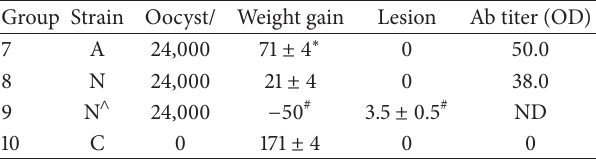
Table 3: White Leghorns were immunized with 240 and 2400 nor- mal (N) or altered (A) oocysts of E. tenella with a two-week interval. Infected control group (N ∧ ) received no previous immunization before final challenge. Remaining birds were challenged each with 24,000 normal oocysts. Controls (C) received (0) sham inoculation. N ∧ lost weight the most and developed moderately severe lesions. Body weight gain/g was significantly higher in uninfected animals and those immunized with altered compared with the normal organisms and there was weight loss in unimmunized animals. N = 6 animals/group. # 𝑝 < 0.01 , ∗ 𝑝 < 0.05 . ND = not